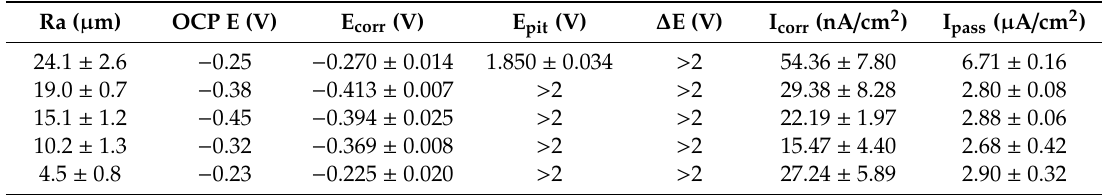
Figure 9. Bio-corrosion results in terms of ( a ) open circuit potential (OCP), and ( b ) potentiodynamic polarization Tafel curves of Ti6Al4V samples with different surface roughness readings, tested in simulated body fluid. Table 2. Summary of bio-corrosion electrochemical properties of EBM Ti6Al4V specimens with different surface roughness readings.